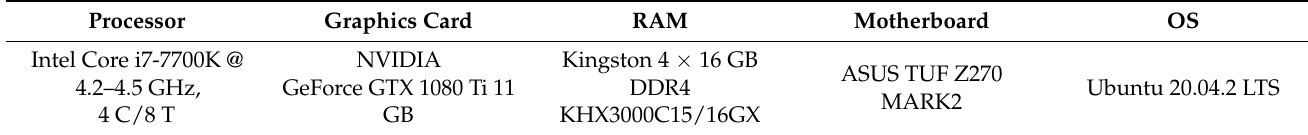
Figure 7. The flowchart of our proposed algorithm. This gesture descriptor then activates an associated subroutine, which sends a com- mand to the YuMi robot server. If desired, it is possible to assign a certain number/com- bination of outstretched fingers to a certain path that the robot arm should traverse or simply to set the angles of the individual joints of the robot. If no hand is detected, the robot can be set to either perform no action or to revert to some predefined base pose.